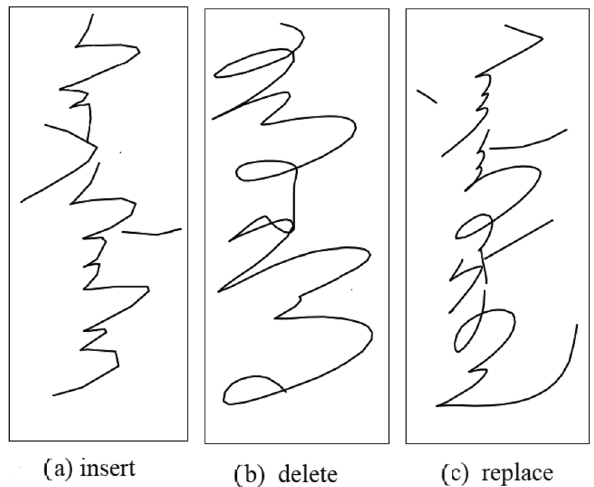
Figure 16. Incorrectly recognized images.